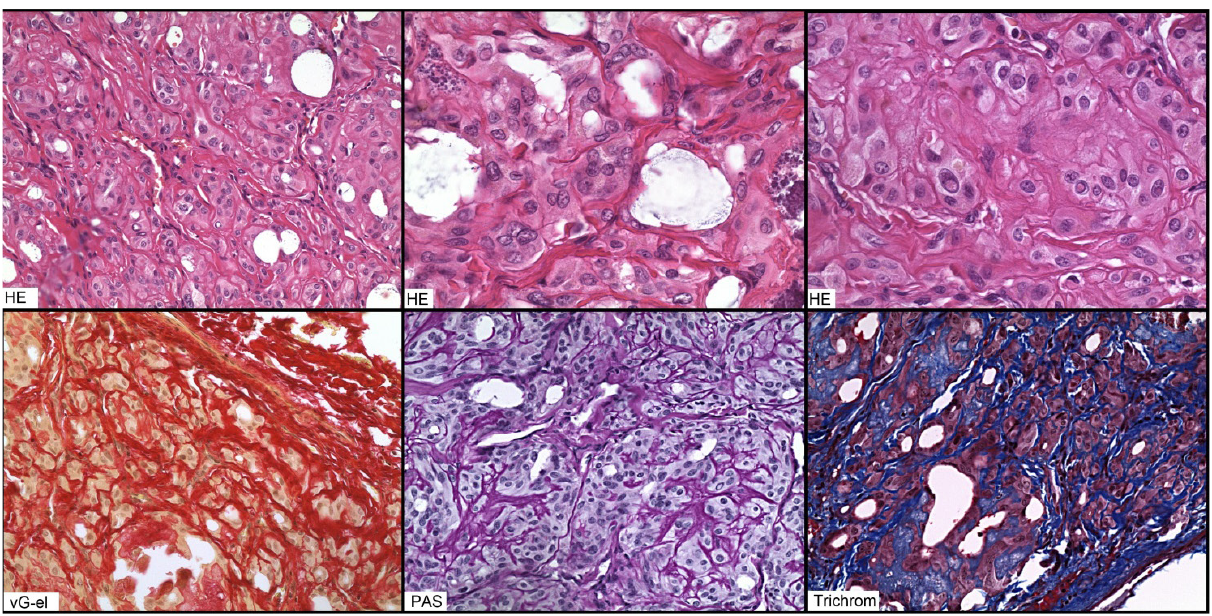
Fig. 3. Histopathology of the resecate. Solid trabeculer and microfollicular arrangement with inter- and intratrabecular fibrosis. Nuclei with the features of PTC nuclei. HE, vG – el, trichrome, PAS staining. Obj. magnif. 20× and 40×.